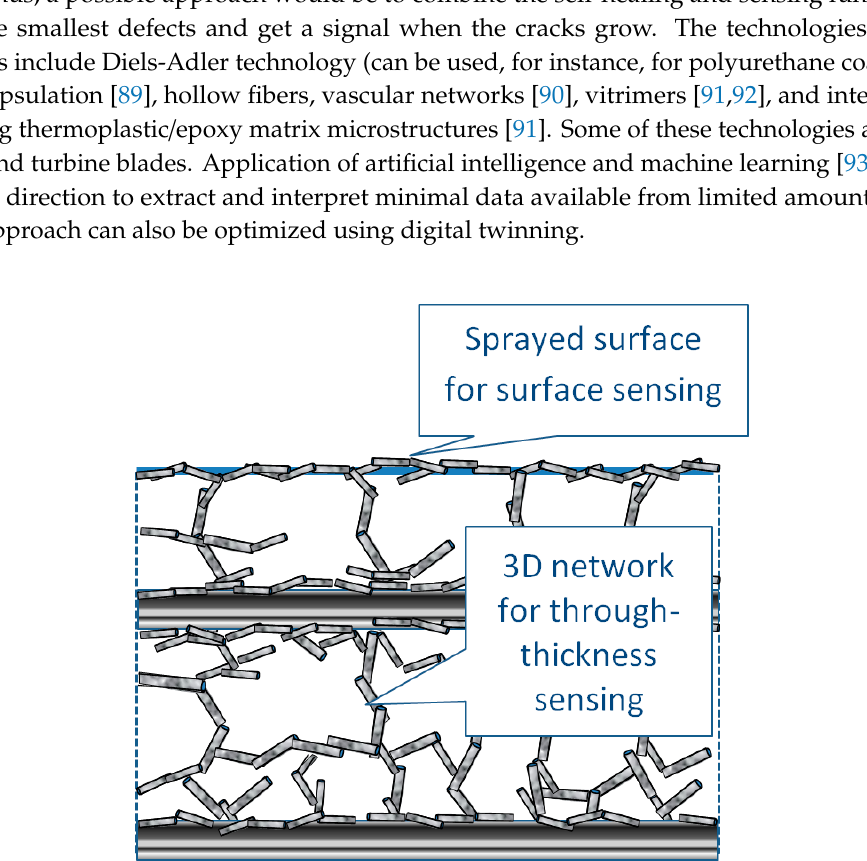
Figure 13. Schema of possible distribution of carbon nanoparticles: on the surface (for surface sensing), on interfaces (for toughening, sensing, and fatigue) [94], and a 3D network in the matrix (volume sensing).